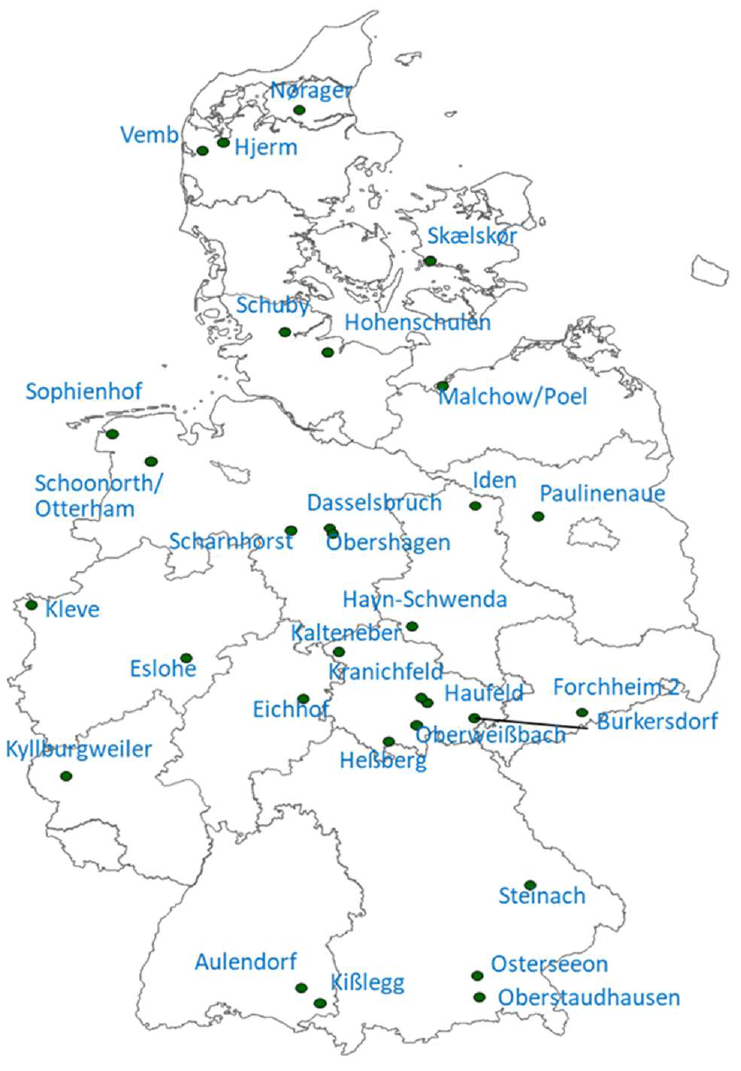
Figure 2. Locations of the national ryegrass variety trials in Germany and Denmark, used for the comparison of two models, GrasProg1.0 and APSIM, for the prediction of grass growth. Table 1. Site descriptions and meteorological stations (Met Station) used for the modelling. DWD (= Germany’s National Meteorological Service, Der Deutsche Wetterdienst) was used for the model- ling. Lon = longitude, Lat = latitude in degrees, Alt = altitude in meters above sea level, PAW = plant